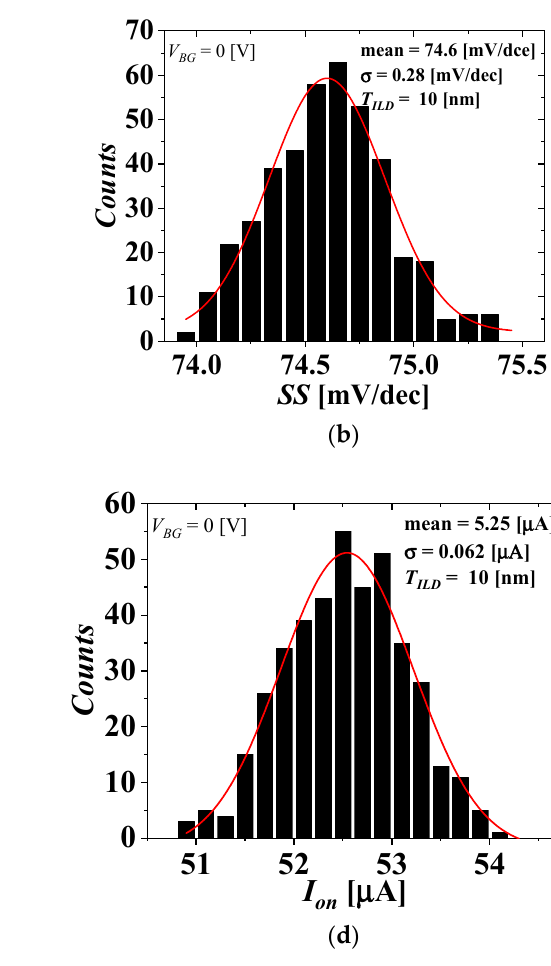
Figure 5. The distributions of the electrical parameters of the top-tier NMOS considering the WFV effects of both the top- and bottom-tier gates when V BG = 0 V. ( a ) V th , ( b ) SS, ( c ) I off , and ( d ) I on .